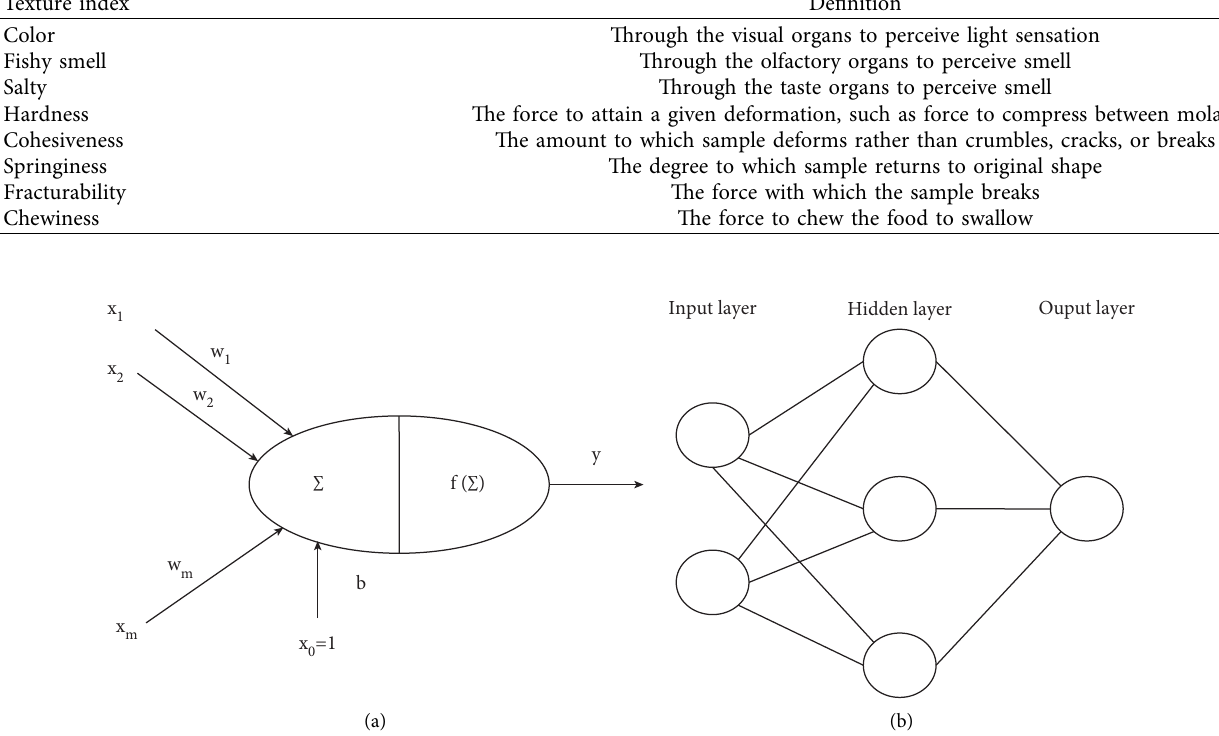
1 , x 2 ,. . ., x m ) are the inputs; ( v � 􏽐 R x w + b ); f() is the activation function; i i i � 1